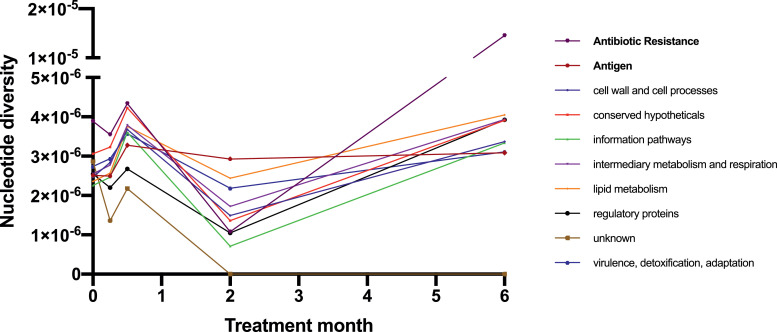
Change in mean nucleotide diversity (π) over time according to gene functional categories (solid icons). Two additional redundant categories are also plotted (bold text).